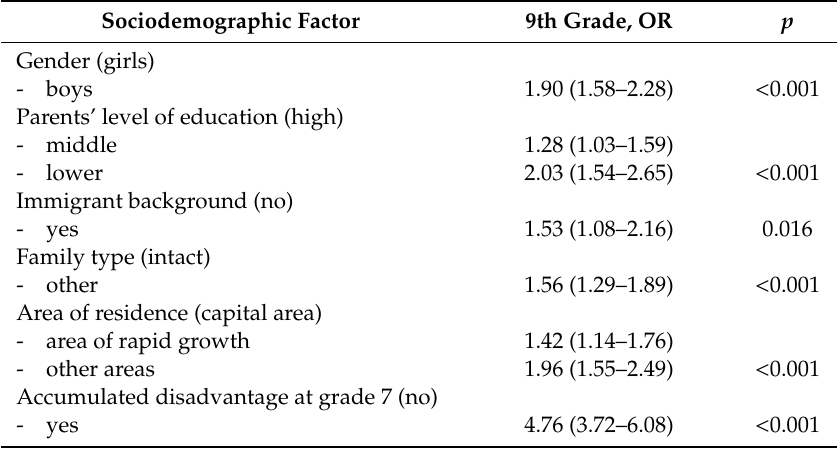
Table 5. Odds ratios (OR) of sociodemographic factors accounting for accumulated disadvantage at the 9th grade. Logistic regression analysis. ( N =